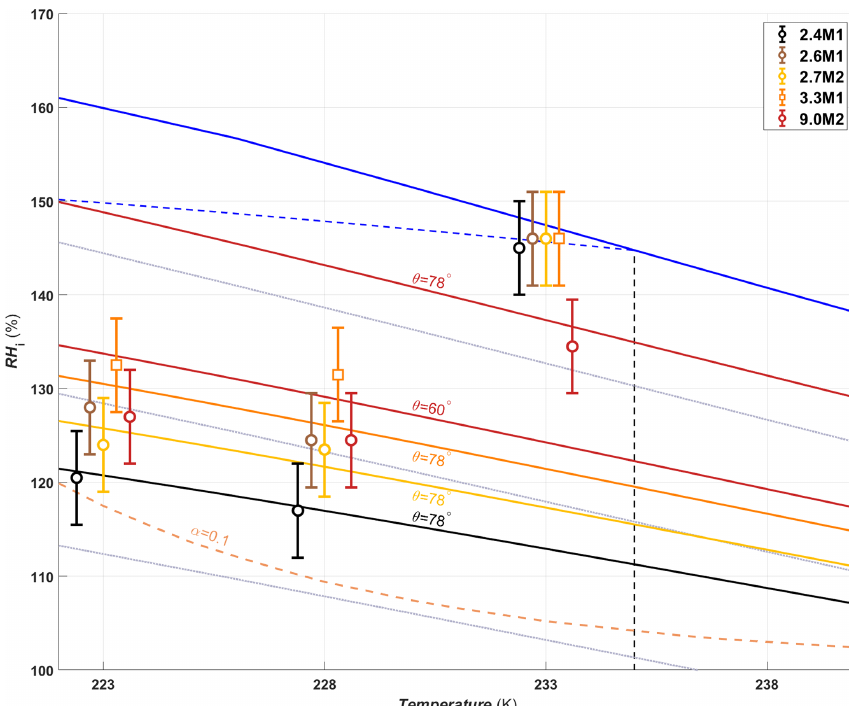
Figure 8. Average RH i required to reach an AF 0 . 05 for methylated silica samples of different pore diameters. The symbols are offset by ± 0 . 3 or 0.6K from the experimental temperatures to make the points more visible. Pore filling lines are given for 2.4 (black line), 2.7 (gold line) and 3.3nm (orange line) pores assuming a water contact angle of 78 ◦ . For 9.0nm pores the pore filling lines are plotted assuming water contact angles of 60 and 78 ◦ (red